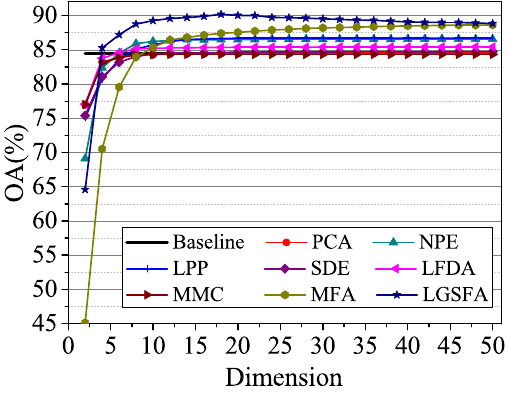
Figure 9. OAs with respect to different dimensions on the Salinas data